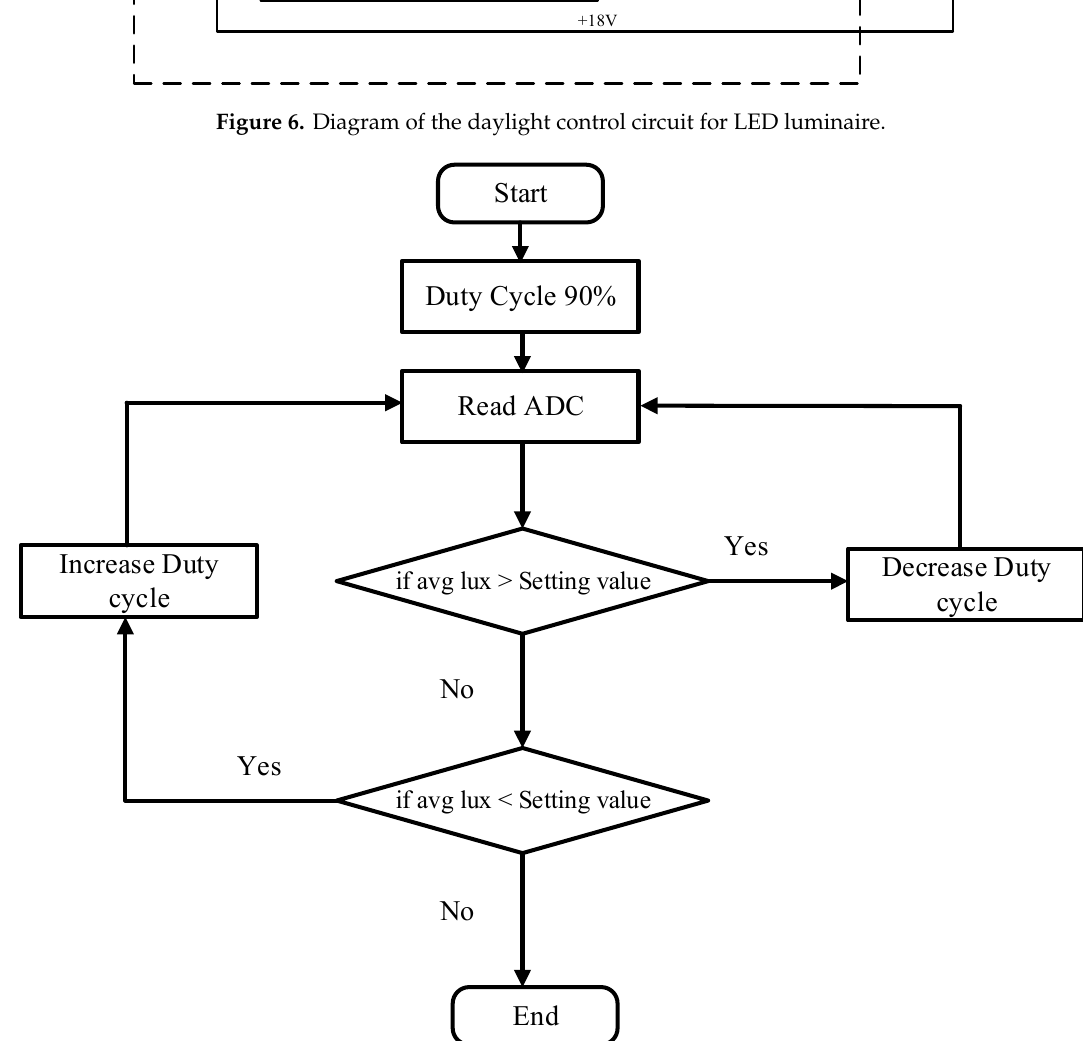
Figure 7. Flowchart of the operation of the proposed LED daylight control circuit.